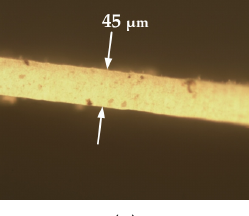
Table 4. Chemical composition of AAO nanoporous membranes.